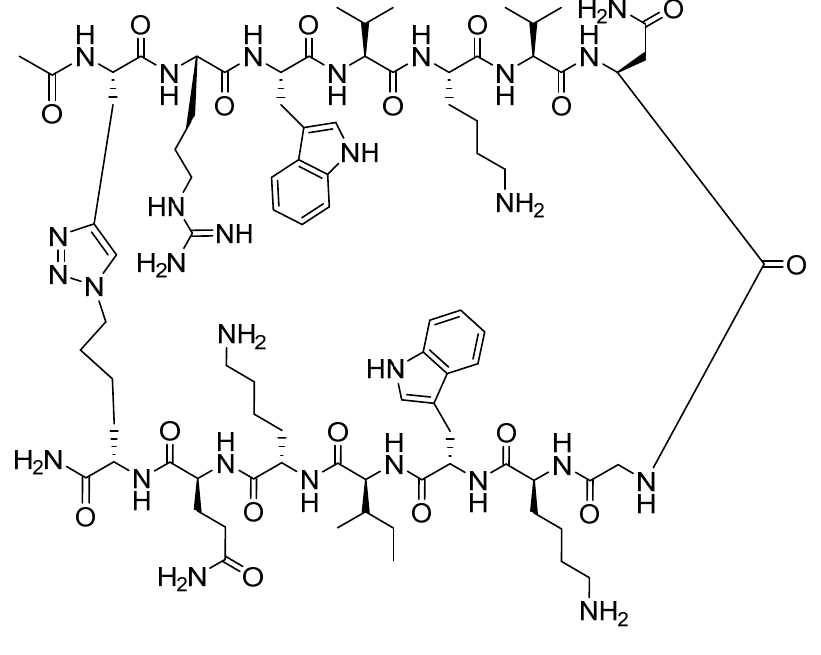
Figure 15. Structural improvement via side chain triazole